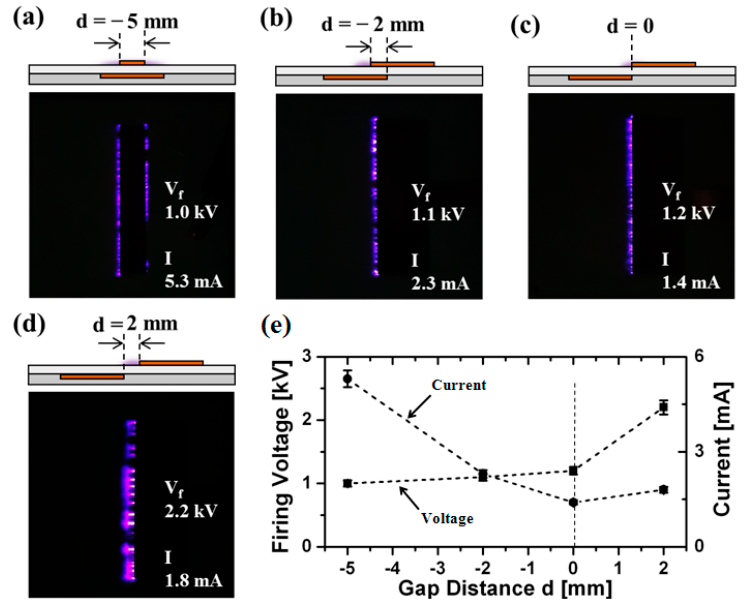
Figure 4. Pictures of the planar discharge on the dielectric surface at the ignition voltage ( V f ) in the dielectric barrier discharge (DBD) structure of Figure 1c with the both-side electrodes: overlapped 5 mm at the center in ( a ), overlapped 2 mm at the edge in ( b ), no gap distance ( d ) = 0 in ( c ), and d = 2 mm in ( d ). And the graph of firing voltage and current versus the gap distance d in ( e ) where the negative value of gap distance d means the overlapped electrodes.